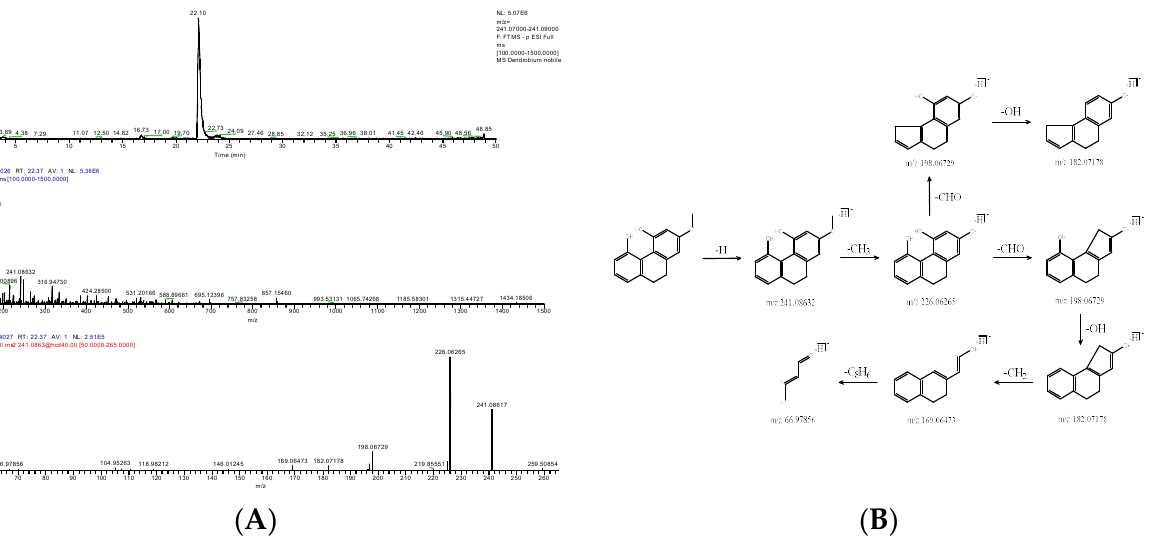
Figure 6. Extracted ion chromatogram: MS 1 and MS 2 spectra in positive ion mode ( A ) and negative ion mode ( B ), and proposed main fragments of ephemeranthol B (DN 30) ( C ).